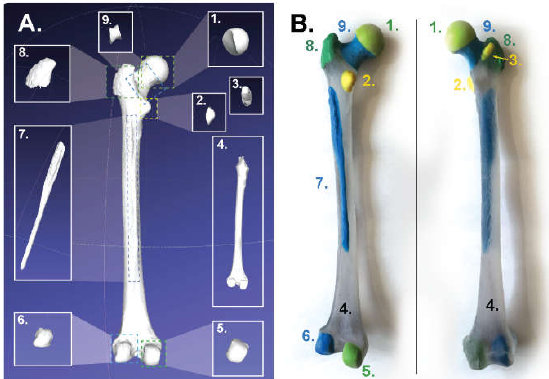
Figure 1. Panel A: Stereolithography (STL) source and split files for the femur (posterior view). Panel B: Poly-jet prints with multiple colors showing posterior and anterior views. Features include 1. head, 2. lesser trochanter, 3. intertrochanteric line, 4. body, 5. medial condyle, 6. lateral condyle, 7. gluteal tuberosity and linea aspera, 8. greater trochanter, and 9. neck.